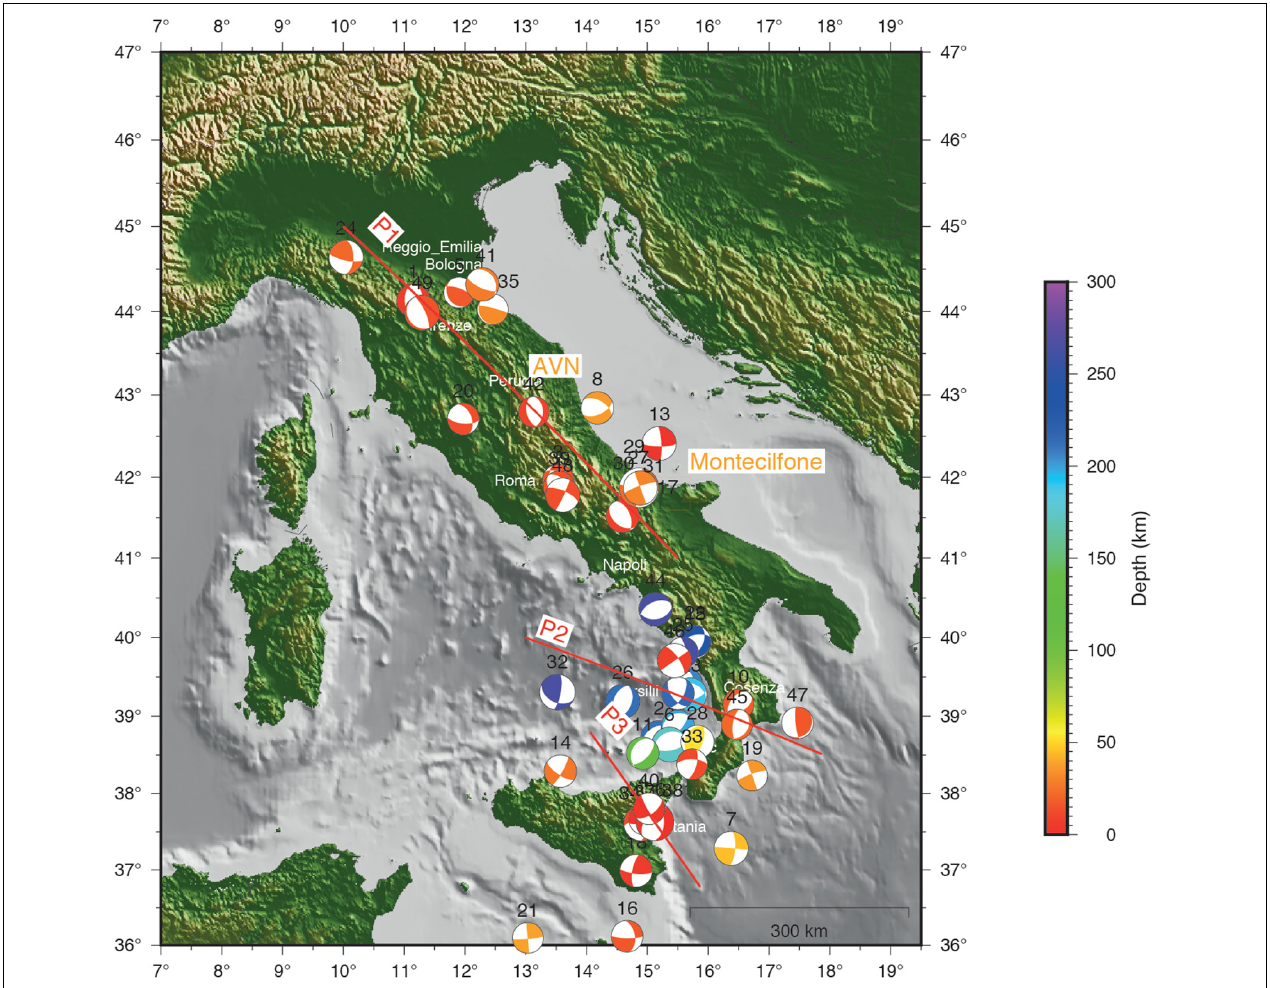
FIGURE 4 | FPFIT focal solutions for the analyzed earthquakes M ≥ 4.0 reported in Supplementary Table 1 , in the “Italy,” “muccia,” and “montecilfone” areas. AVN-Box is the area of the Amatrice–Visso–Norcia seismic sequence; P1: trace of the vertical cross section in Figure 5A ; P2: trace of the vertical cross section in Figure 5B ; P3: trace of the vertical cross-section in Figure 5C . Color scale is related to hypocenter